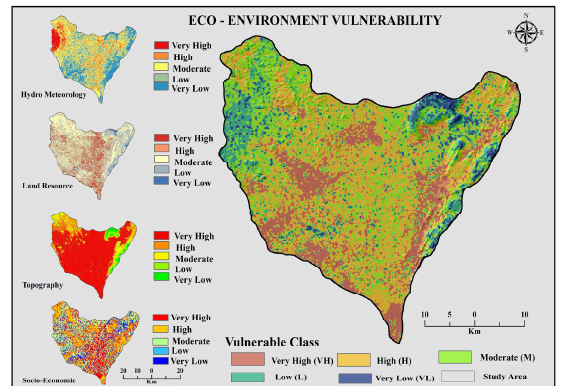
Figure 7. Spatial Distribution of Eco-Environmental